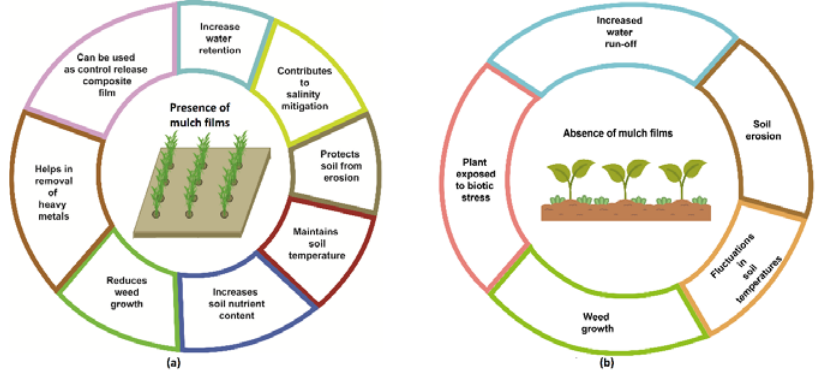
Figure 3. A comparison of the effect of mulch films on plant growth and soil—( a ) in the presence of mulch films and ( b ) in the absence of mulch films.